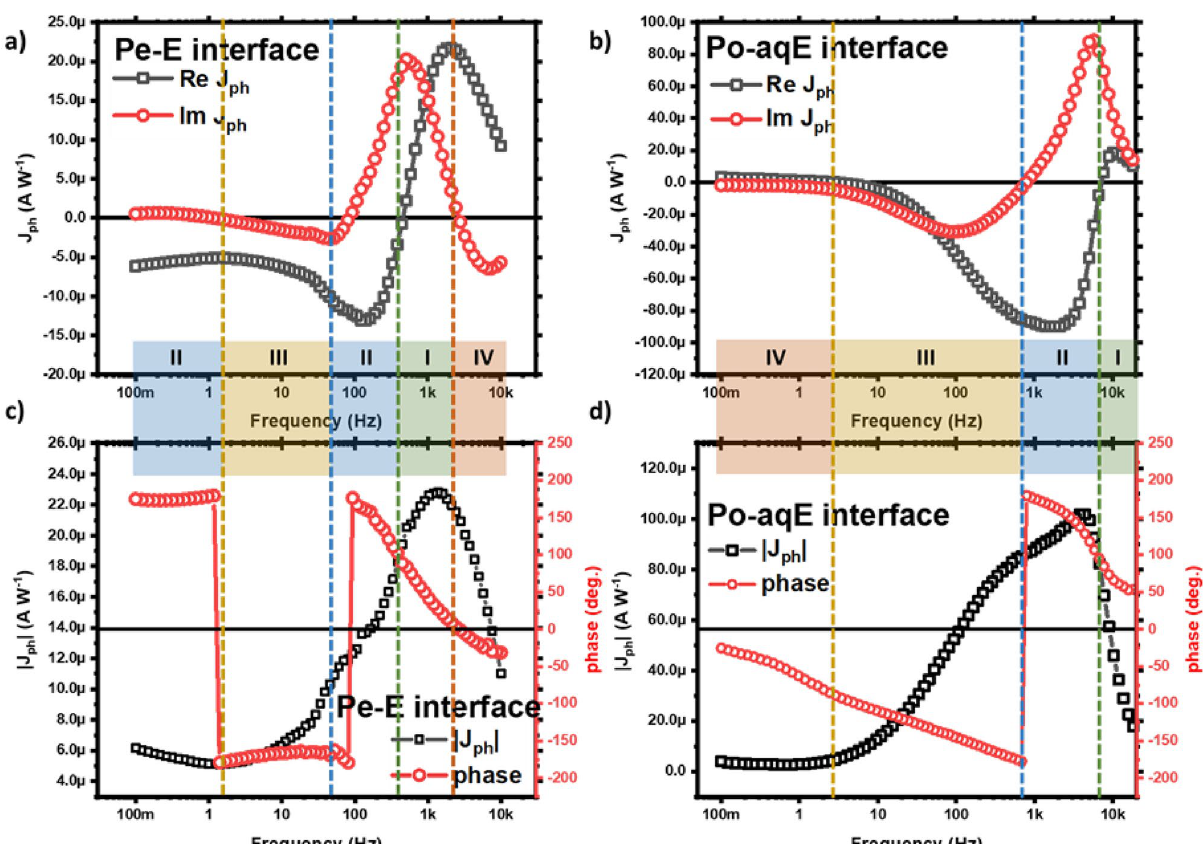
Figure 6. Real and imaginary photocurrent versus frequency plot and Bode (|Z| and phase shift vs. frequency) plots for perovskite–electrolyte ( a , c ) and P3HT-aqueous electrolyte ( b , d )